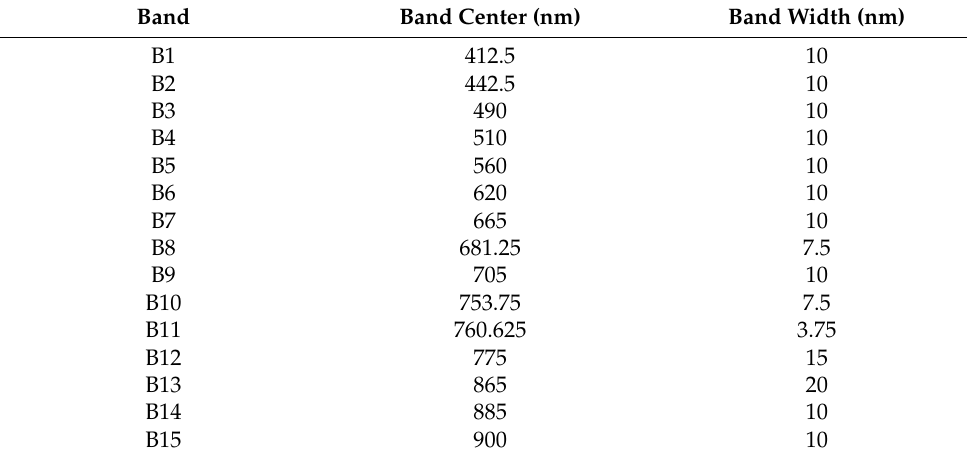
Table 3. Specifications of MERIS onboard the ENVISAT